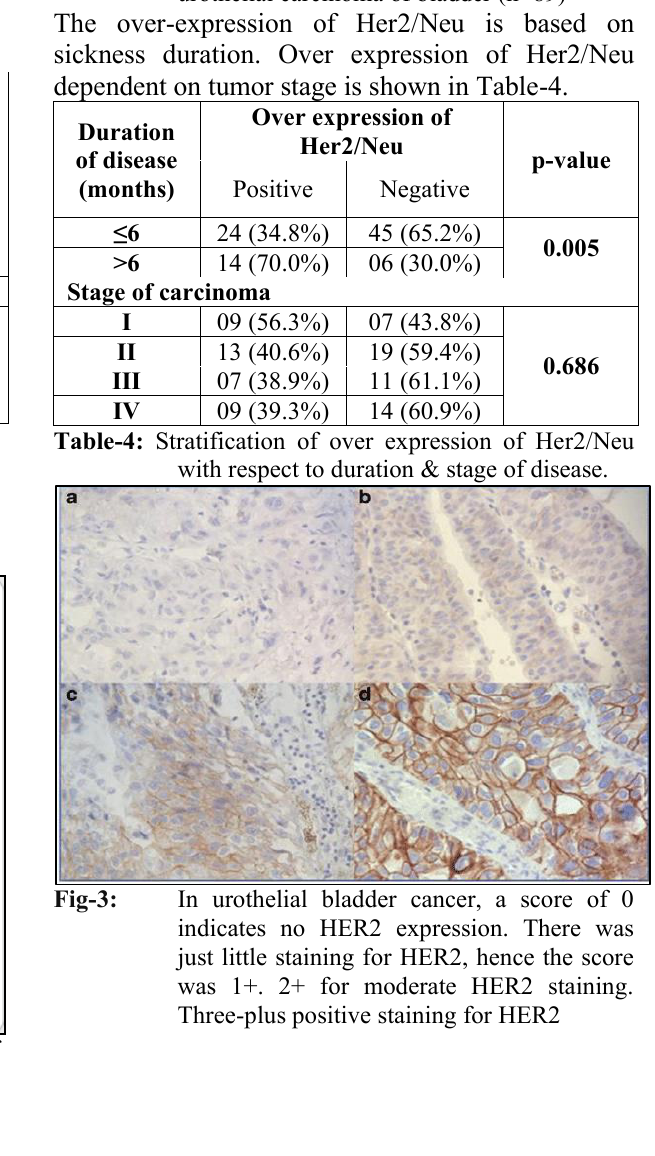
Table-2: Distribution of patients according to duration of disease.